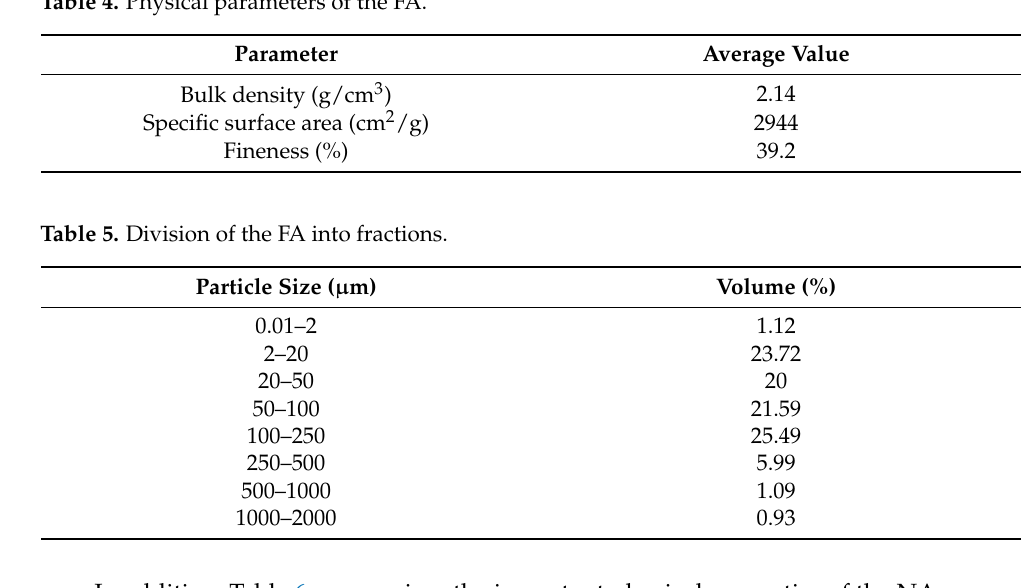
Table 4. Physical parameters of the FA.